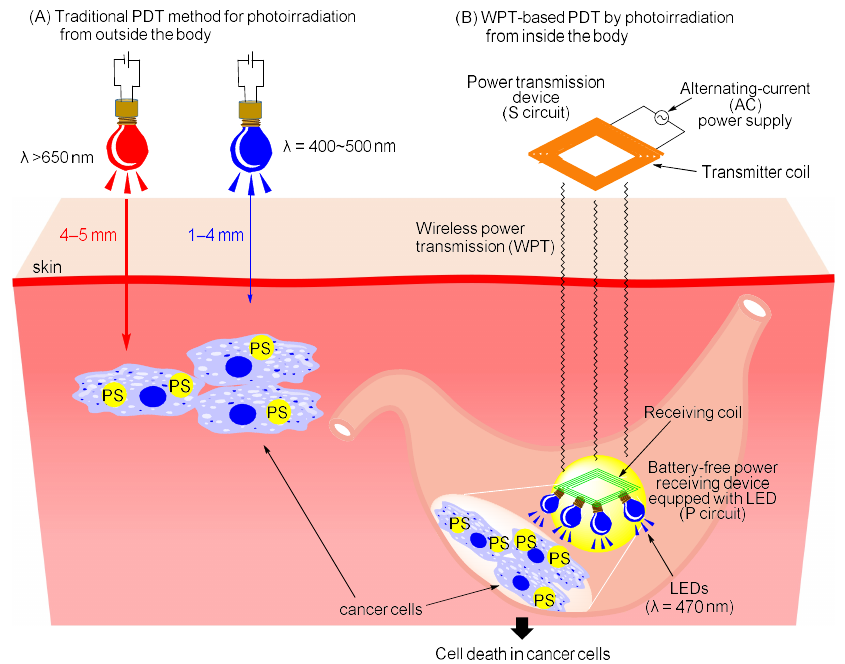
Figure 1. A schematic proposal of wireless power‑transmission‑based photodynamic therapy of cancer (WPT‑PDT), in which photoirradiation is conducted inside the body ( B ), compared with the currently accepted PDT that uses irradiation from outside the body ( A ). PS depicts a photosensitizer.